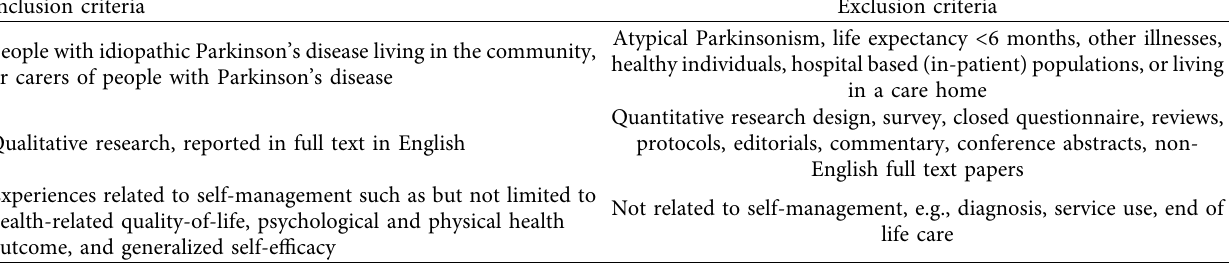
Table 1: Inclusion and exclusion